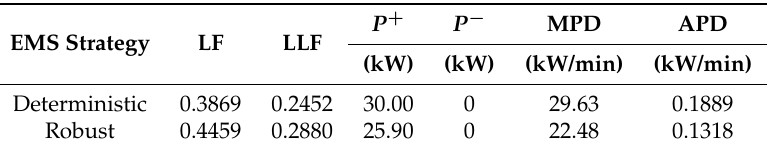
Table 5. Quality indexes for the power profile of the main grid. APD: average power derivative; LF: load factor; LLF: load loss factor; MPD: maximum power